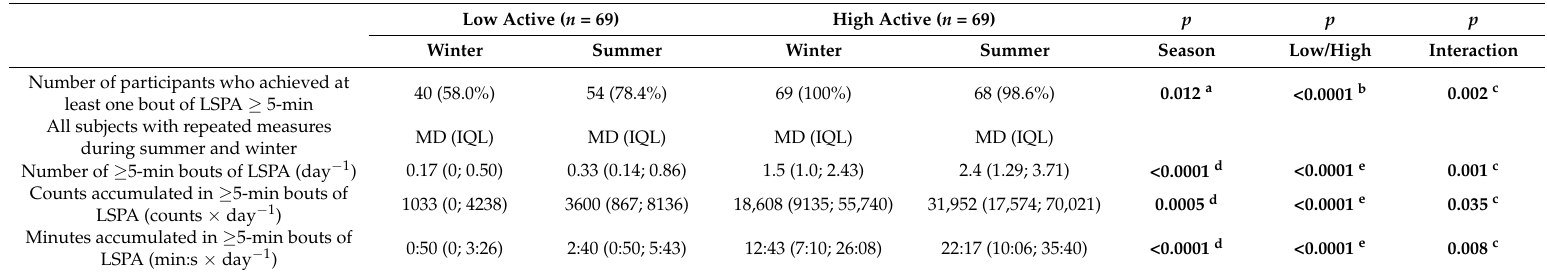
Table 3. Median value (MD) and inter quartile limits (IQL) for the means of the valid day values, for ≥ 5-min bouts of LSPA for sub-population of participants with repeat visits during summer and winter, presented separately for low- and high-active participants. Low vs. high active participants were separated by the median of average TPA for summer and winter. Also, the proportion of participants who reached any bout of ≥ 5-min of LSPA. Low Active ( n = 69) High Active ( n = 69) p p p Winter Summer Winter Summer Low/High